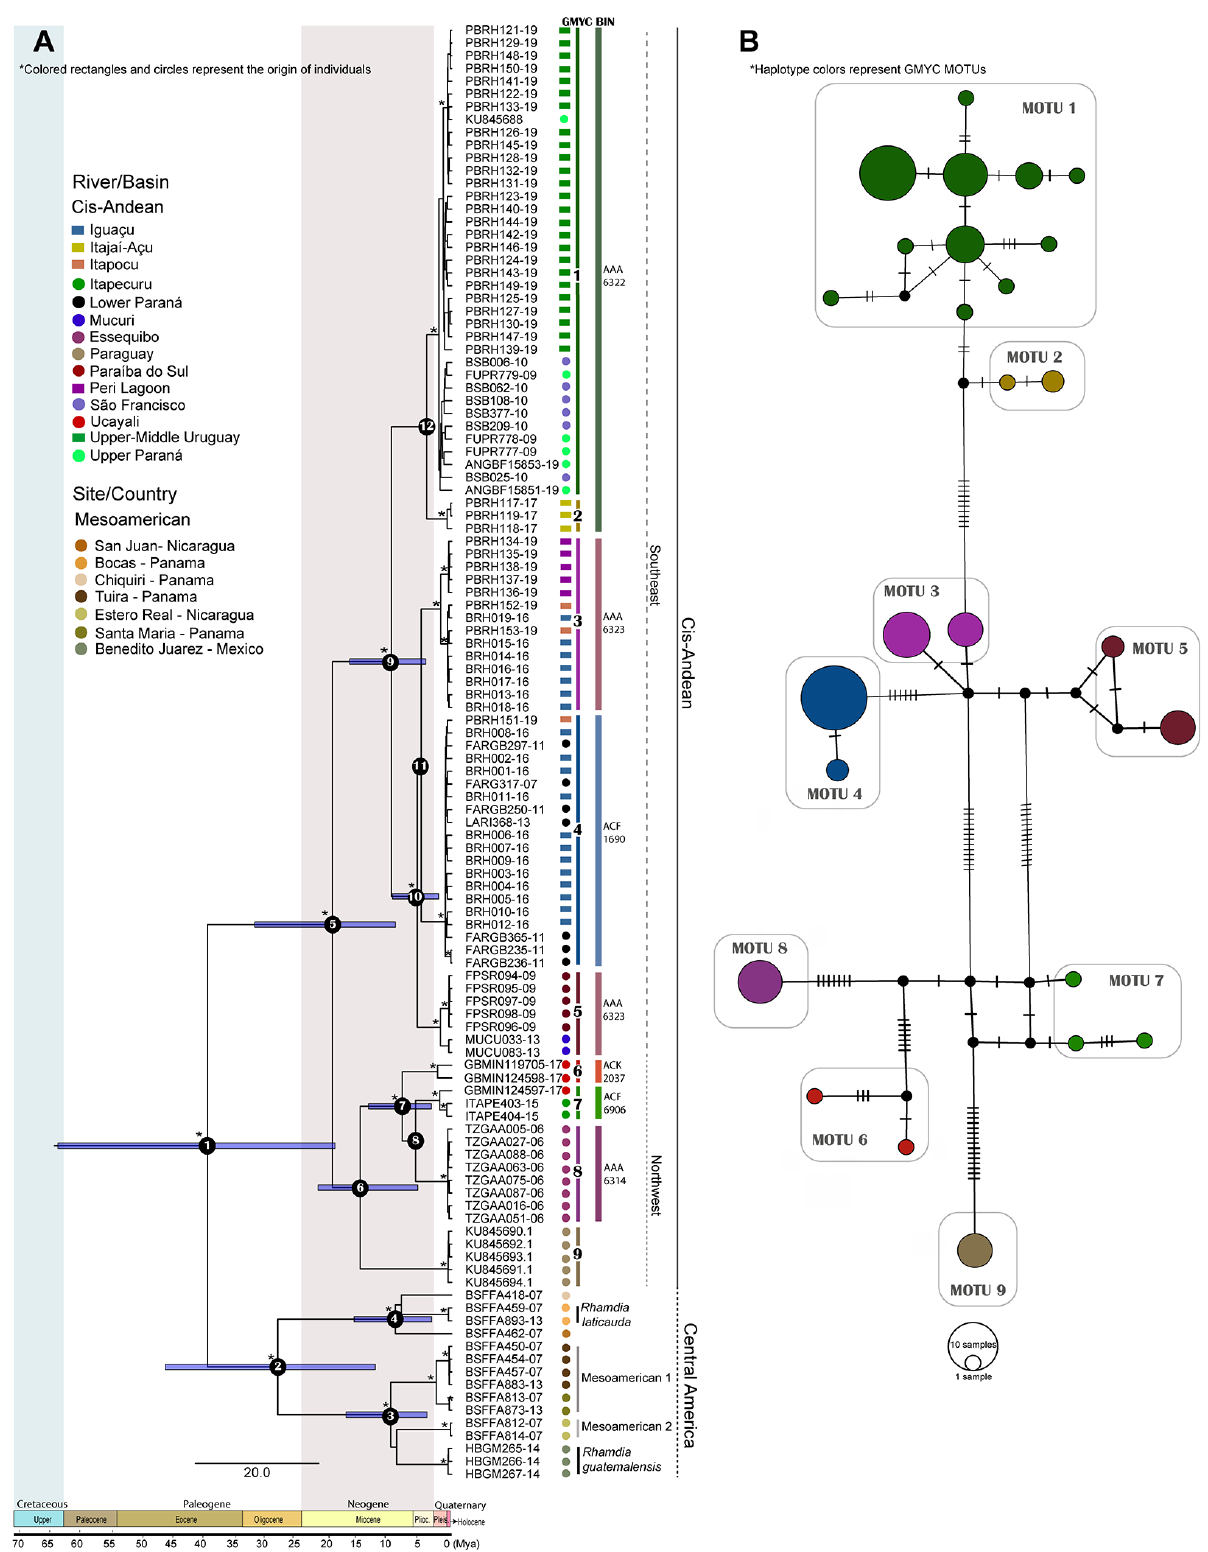
Figure 2 – Time-calibrated topology of Mesoamerica and cis-Andean Rhamdia with species delimitation analyses (A) and median-joining haplotype network for cis-Andean Rhamdia (B) based on COI sequences. Node numbers represent the diversification events, and asterisks represent posterior probabilities above 0.9. Circles represent samples from BOLD System (http://www.boldsystems.org/), while squares are sequences obtained in this study. In the haplotype network, the circle size is proportional to the number of sequences. There is not sharing haplotypes among MOTUS. Black circles indicate haplotypes not